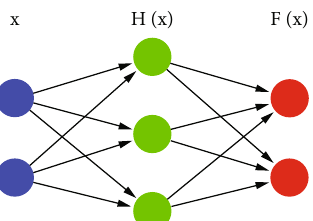
Figure 1: Neural network explanation diagram.